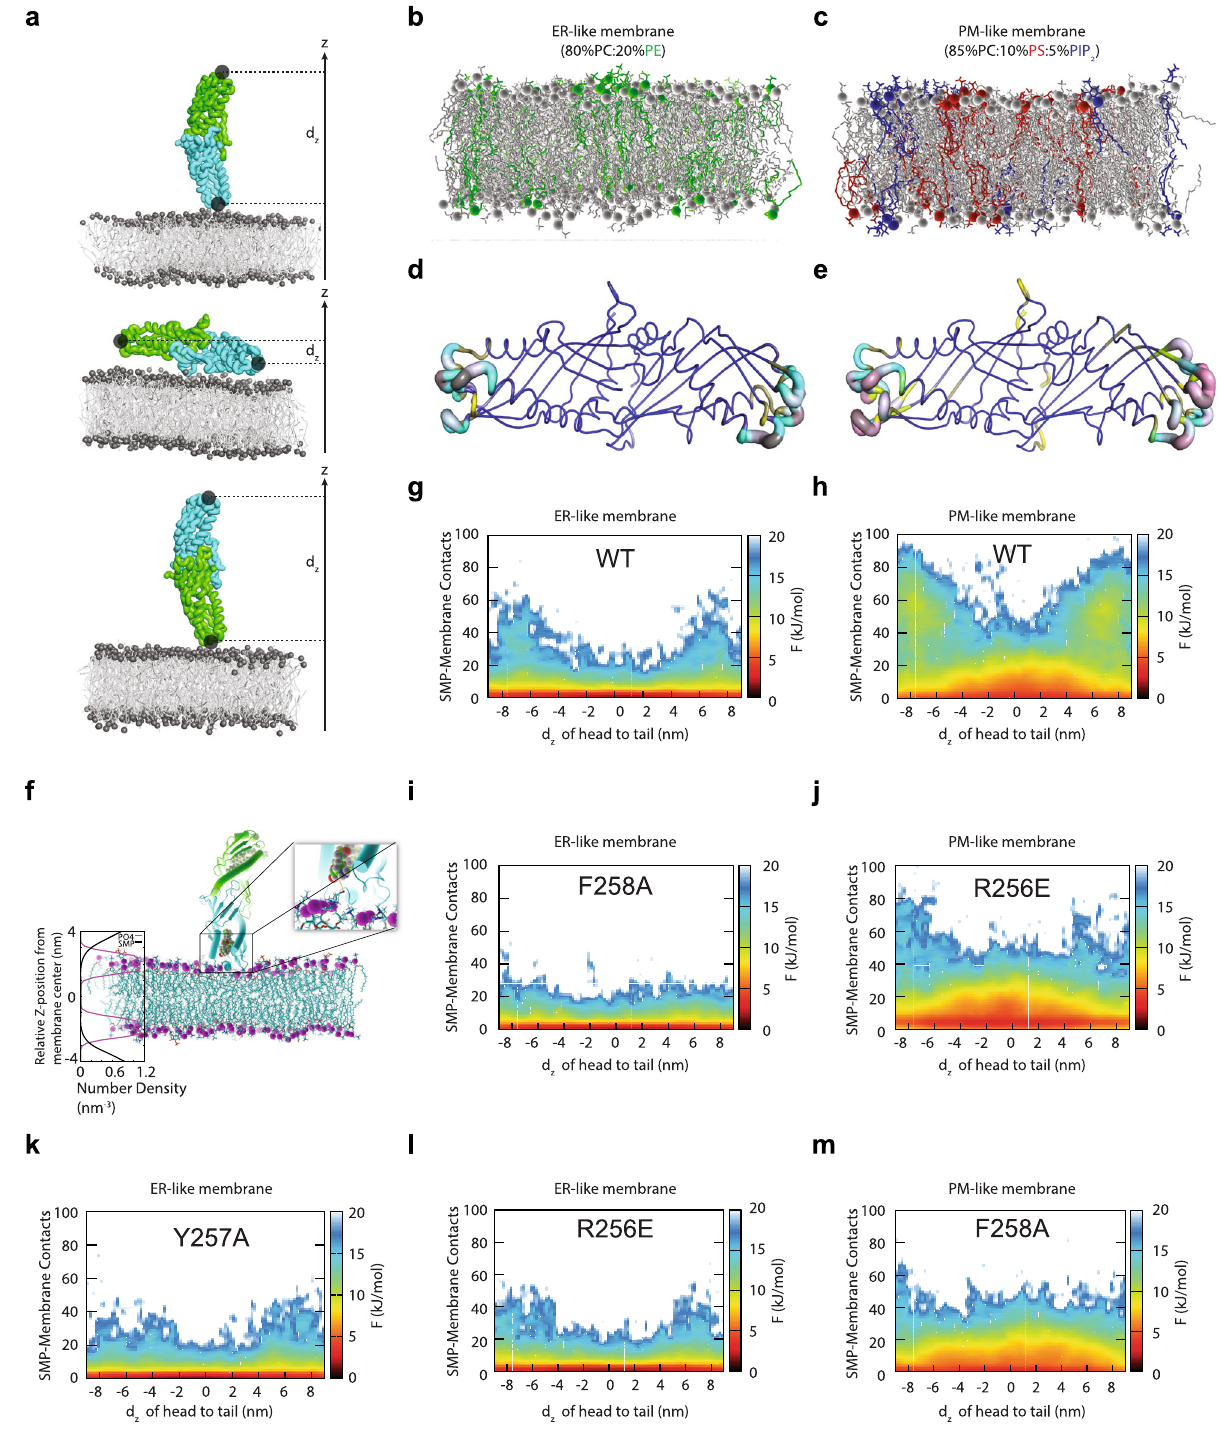
Fig. 5 | Membrane association by the SMP domain is supported by molecular dynamics simulations of E-Syt2 SMP dimer with an ER-like and a PM-like membrane. a , Representative conformations corresponding to the “ standing-up ” and “ lying-down ” boundstates. b ,RepresentativestructureofanER-likemembrane modelconsistingof80%POPC:20%POPE. c ,RepresentativestructureofanPM-like membrane model consisting of 85% POPC:10% POPS:5% PI(4,5)P 2 . d , e The mem- brane binding frequency of SMP residues mapped onto the crystal structure of E-Syt2 (PDB code 4P42) with the ER-like d , and the PM-like membrane e , respectively. The binding frequency is visualized by the thickness of the tube (thinner tube represents lower frequency) and different colors from blue (the lowest frequency), yellow, green, cyan, gray to magenta (the highest